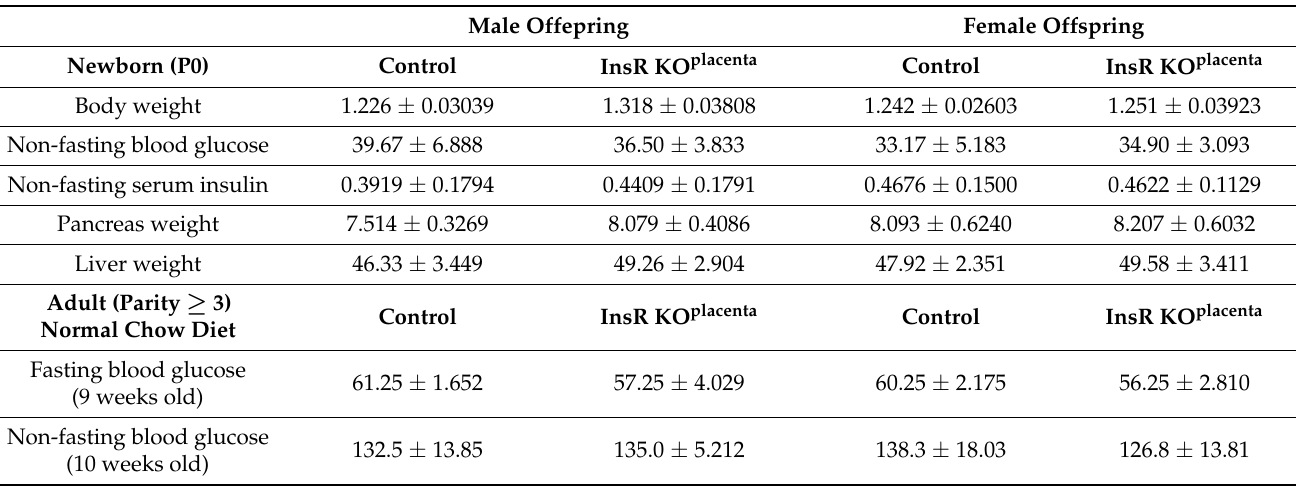
Table 1. Male and female offspring characteristics in newborns (P0) and adults (parity ≥ 3) on a normal chow diet. Newborn characteristics in terms of body weight, non-fasting blood glucose, non-fasting serum insulin, pancreas weight, and liver weight. Adult offspring characteristics in terms of fasting and non-fasting blood glucose levels measured at 9 and 10 weeks of age, respectively. The data are presented as the means ± SEM. Male